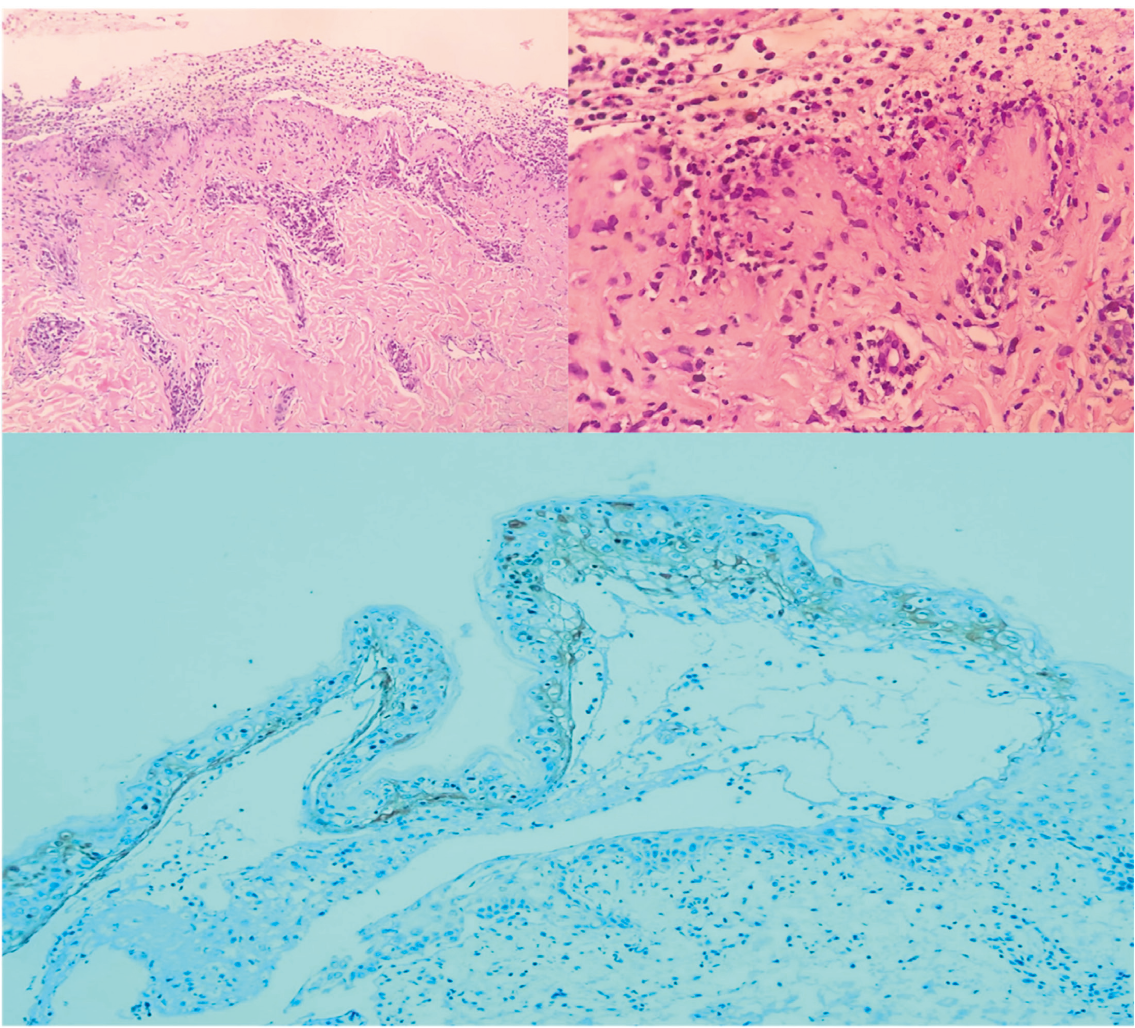
Figure 2: Subepidermal blister with neutrophils and interface dermatitis. Vacuolar alterations at the dermoepidermal interface with necrotic keratinocytes are presented (H&E × 40 and × 100). Immunohistochemical studies showed deposition of IgG at the dermoepidermal junction and within vessel